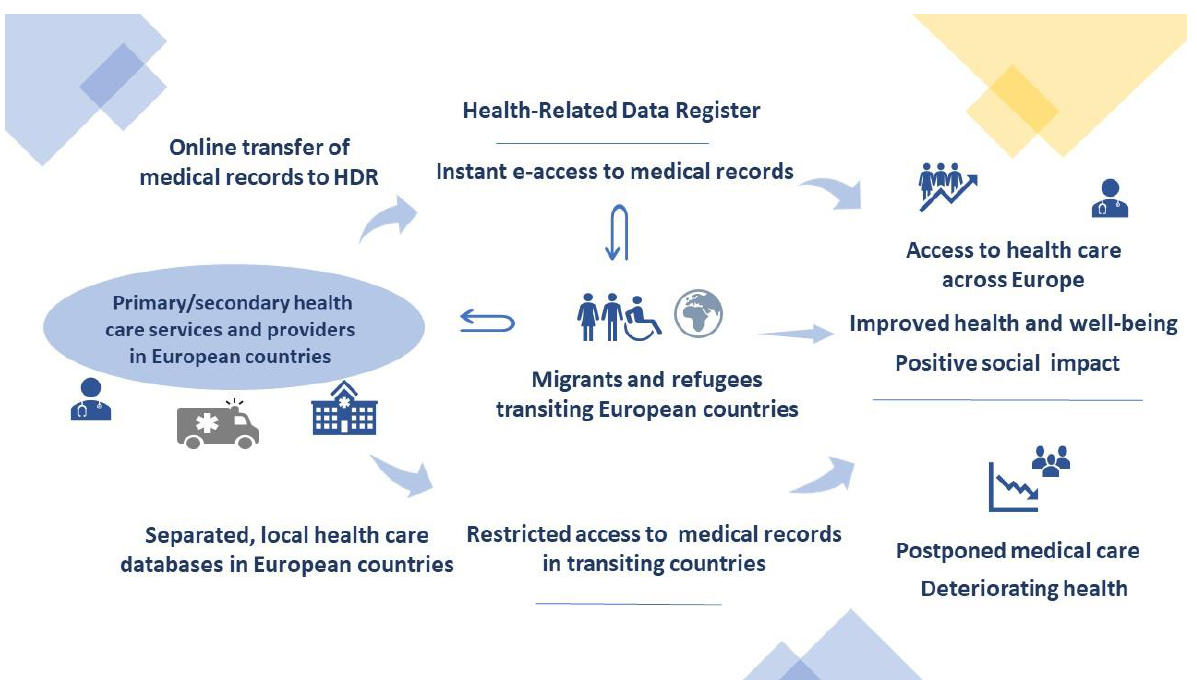
Figure 1. The implications of the introduction of a European register collecting health-related data and its impact on refugees’ well-being.